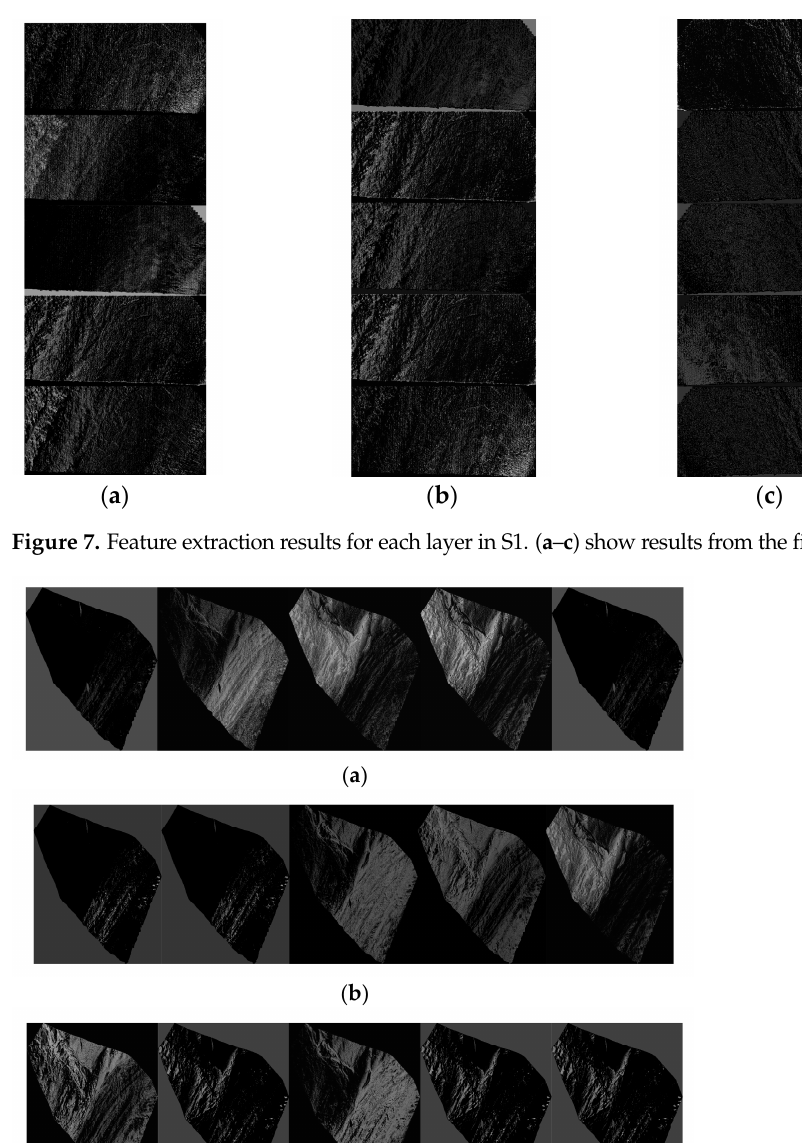
Figure 6. The performance of the RPNet with different numbers of patches. ( a ) S1; ( b ) S2.